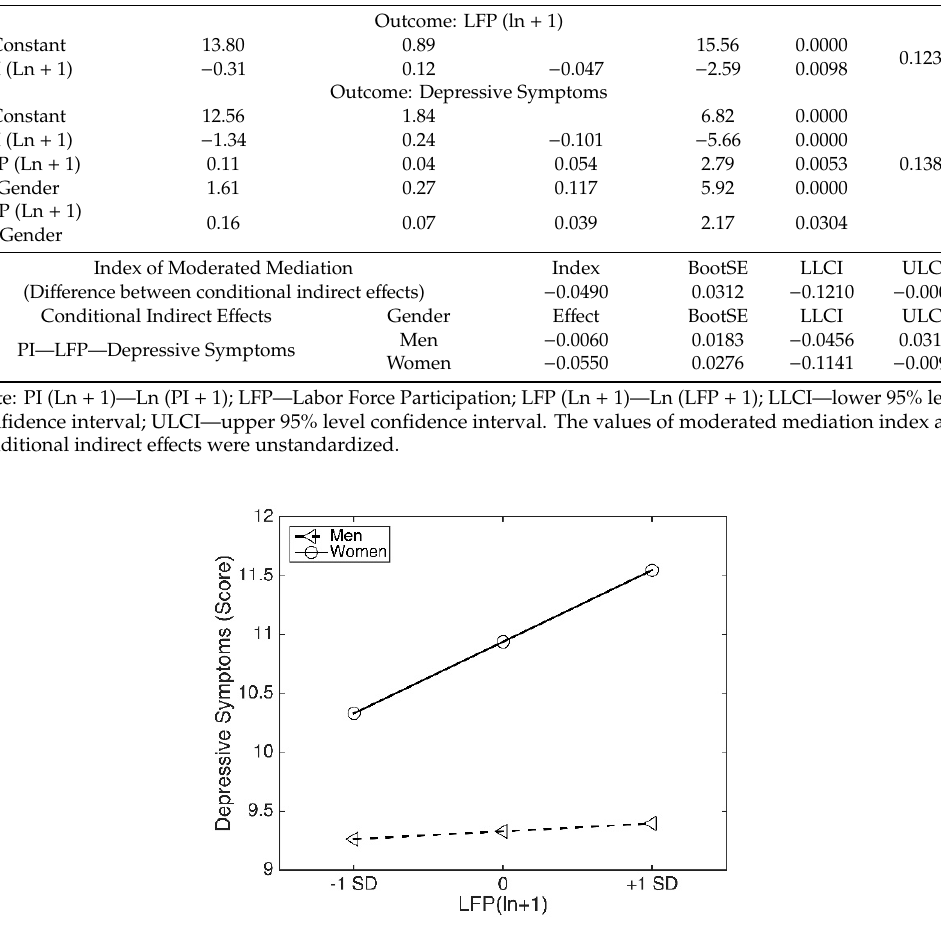
ff ect of gender on the association between LFP and depressive Figure 4. Conditional effect of gender on the association between LFP and depressive symptoms. Figure 4. Conditional e